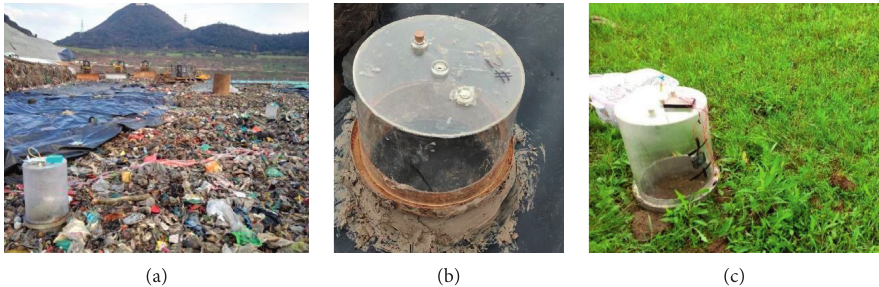
Figure 1: Gas sampling on the different areas of the landfill. (a) Working area. (b) Temporary cover area. (c) Final cover